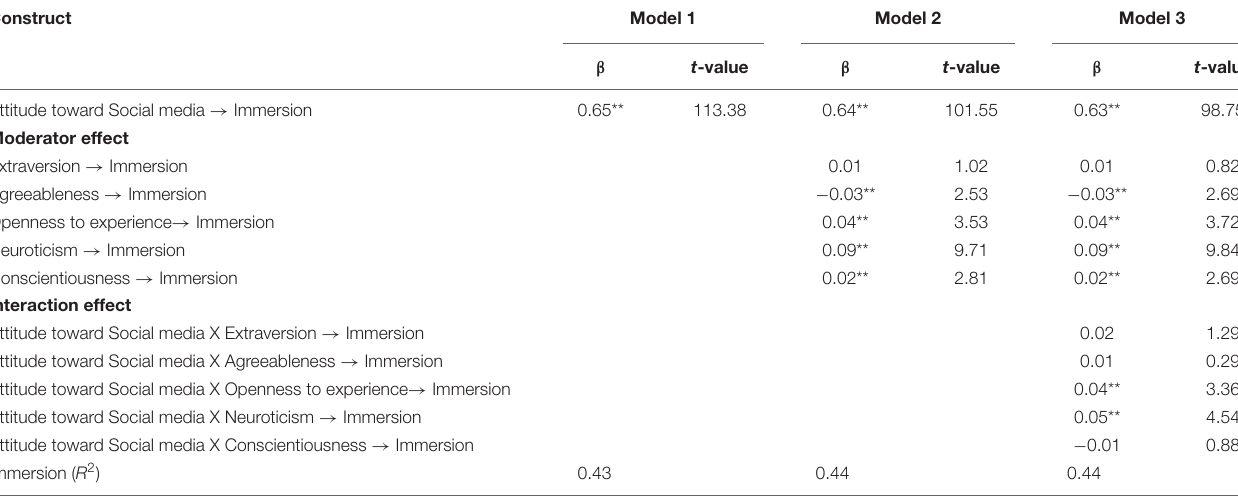
TABLE 4 | Estimation results for